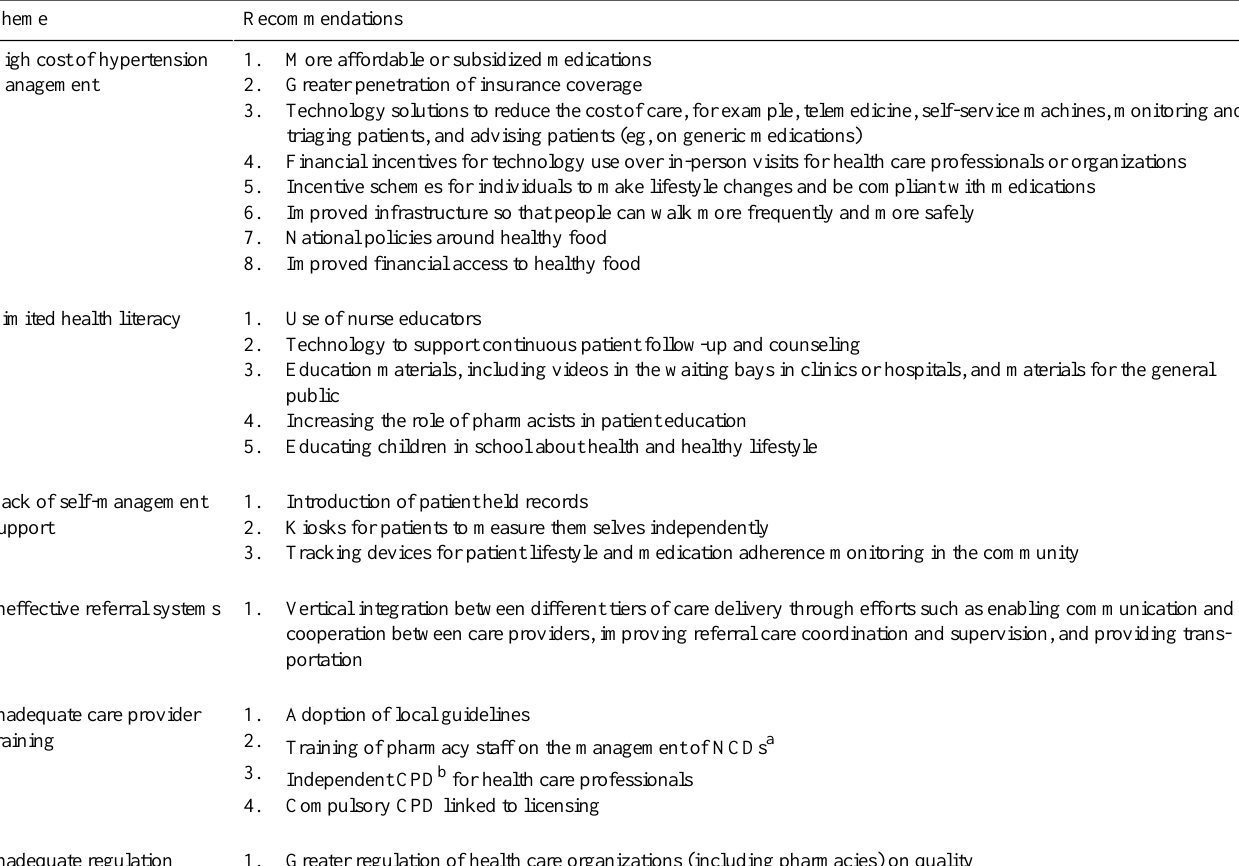
Table 2. Solutions for improving management of hypertension recommended by